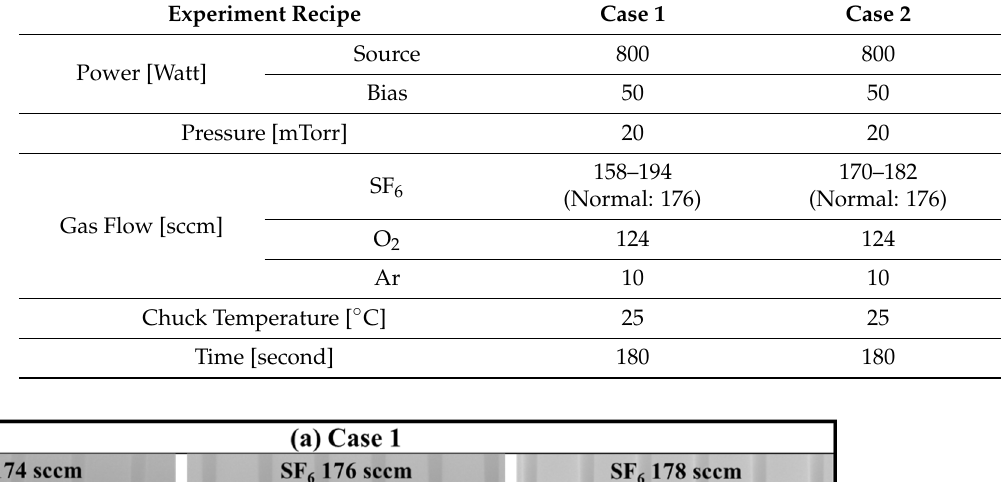
Table 1. Normal/abnormal scenario process recipe.